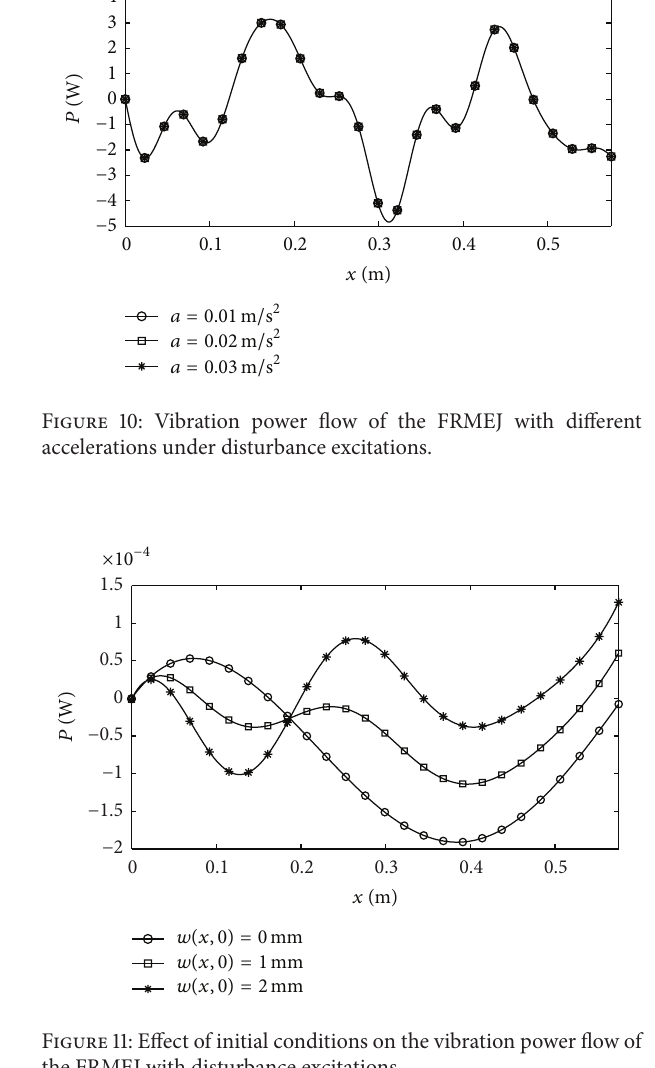
Figure 11: Effect of initial conditions on the vibration power flow of the FRMEJ with disturbance